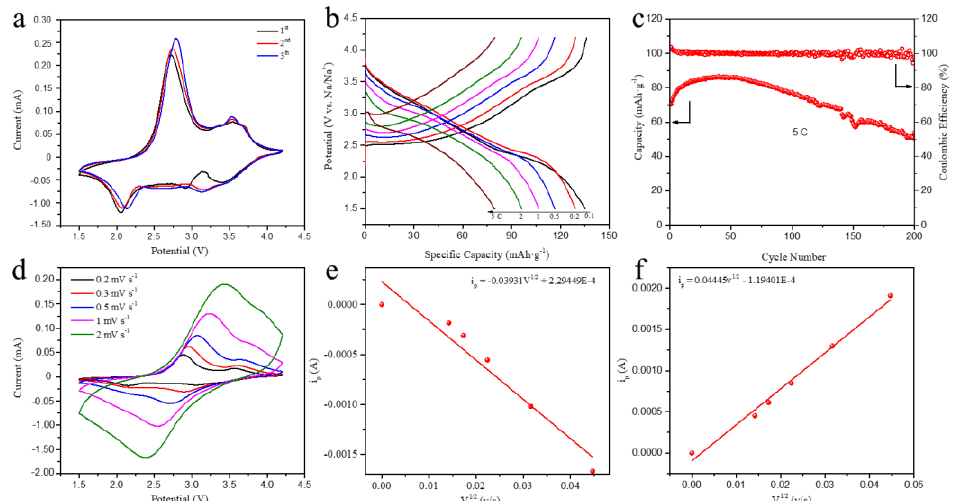
Figure 5. ( a ) The 1st–3rd CV curves, ( b ) charge–discharge curves at different current densities, ( c ) cyclic life at 5 C, ( d ) CV curves at different scan rates and ( e , f ) I p – V 1/2 plots of KFAM-2.